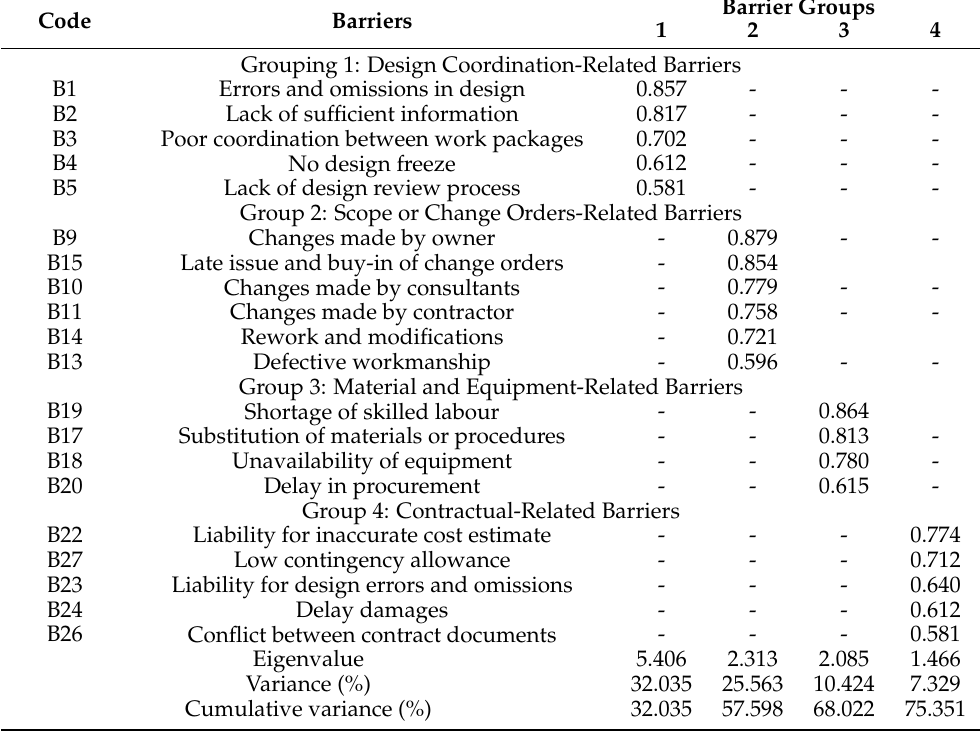
Table 4. Results of factor analysis.